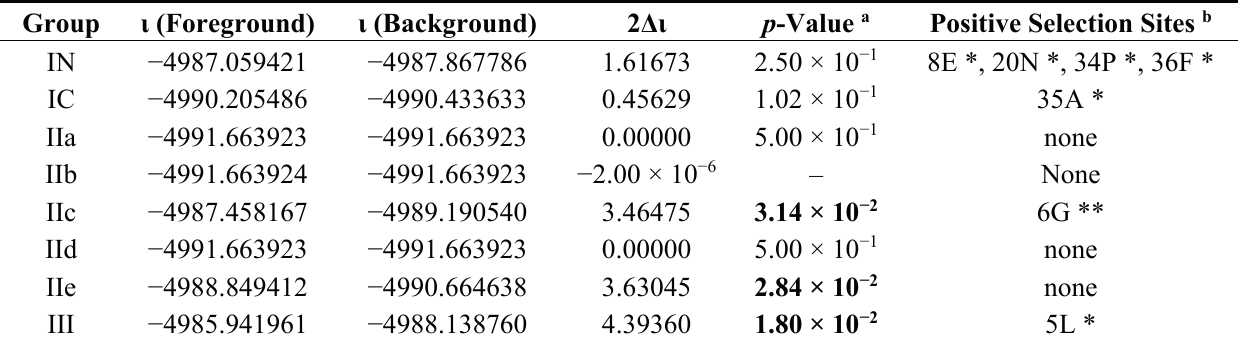
Table 3. Likelihood ratio tests for the branch-site models. ι , log likelihood values, 2 Δι , the test statistic; a bold indicates p < 0.05 (based on the 50:50 mixture distribution of point mass 0 and χ (cid:2869)(cid:2870) ); b amino acid sites estimated to have undergone positive selection by Bayes empirical Bayes analysis. * Posterior probability >95%, ** posterior probability